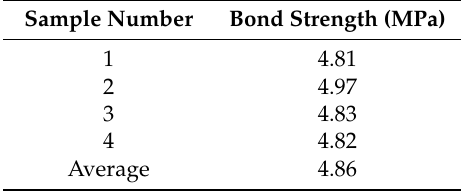
Table 3. Bond adhesion test results of the Al coating using the arc thermal metal spray process.